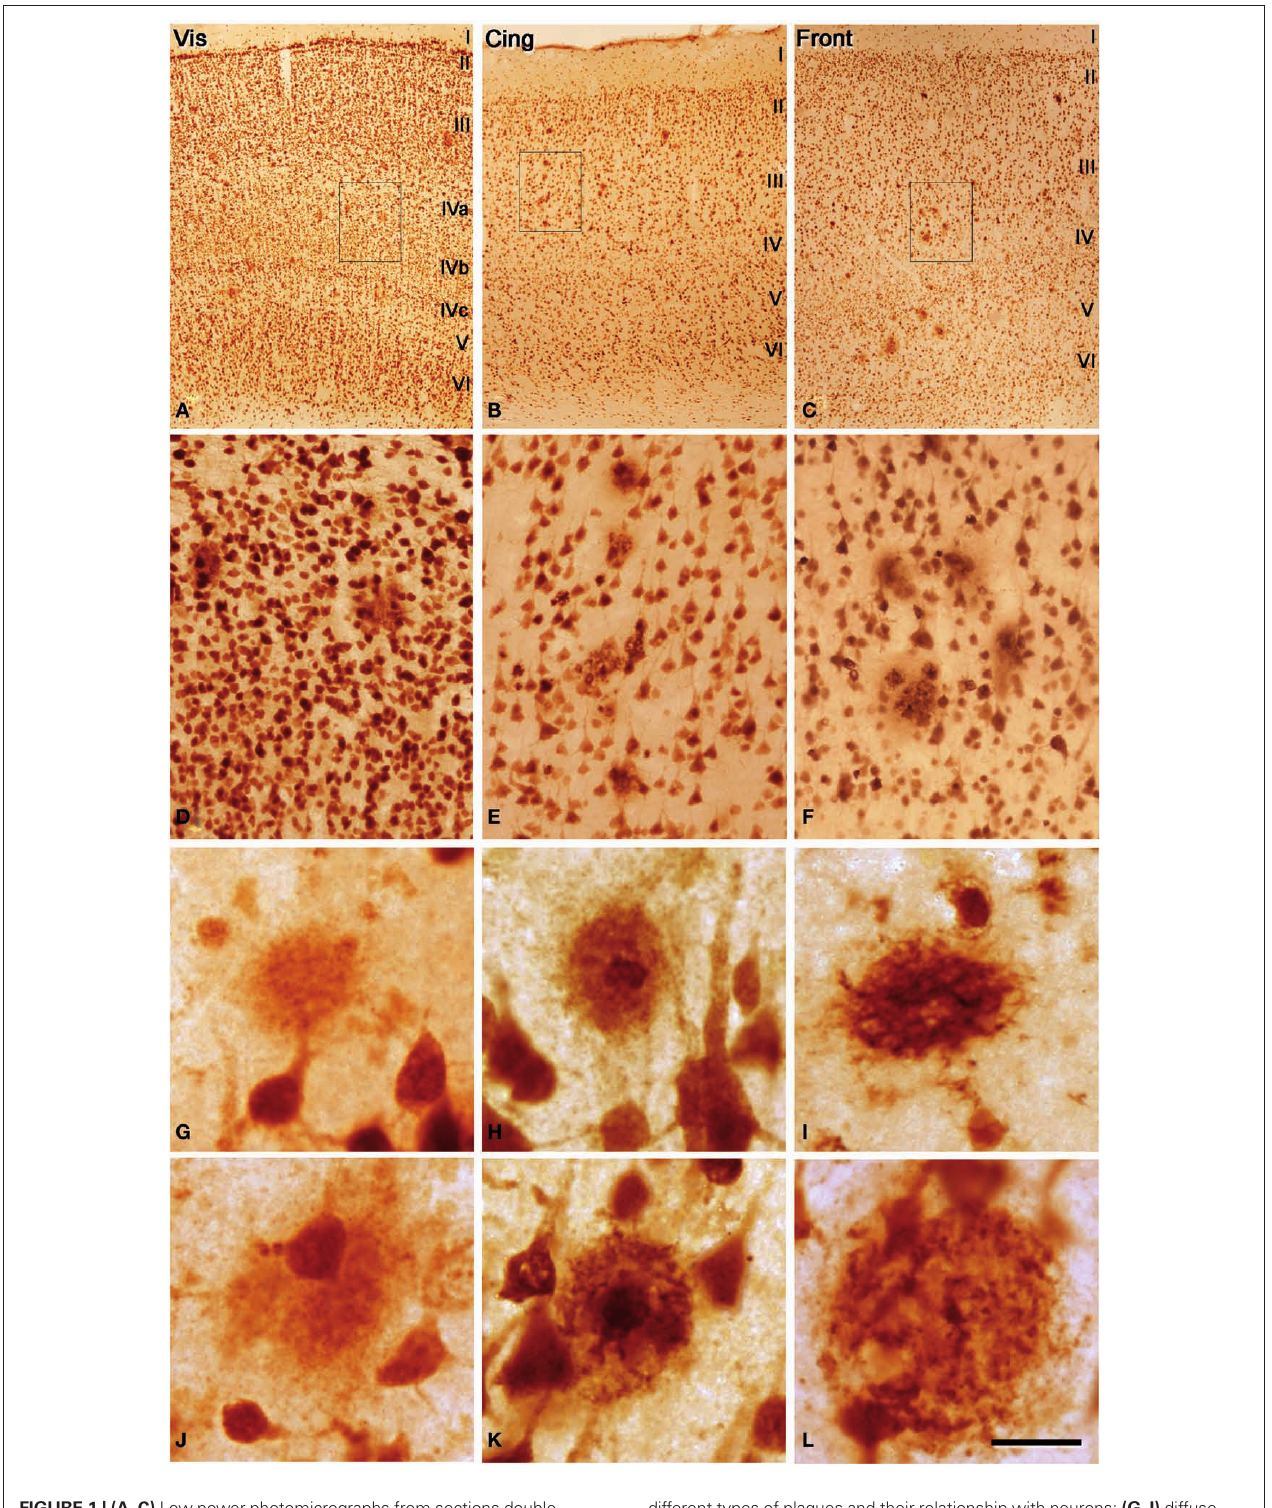
FIGURE 1 | (A–C) Low power photomicrographs from sections double stained for anti-A β and NeuN, showing the pattern of immunostaining in layers I–VI of different cortical areas from patient P3. (A) Visual cortex, (B) cingulate cortex, (C) frontal cortex. (D–F) Higher magnifi cation of boxed areas in (A–C) , respectively. (G–L) High-power photomicrographs showing